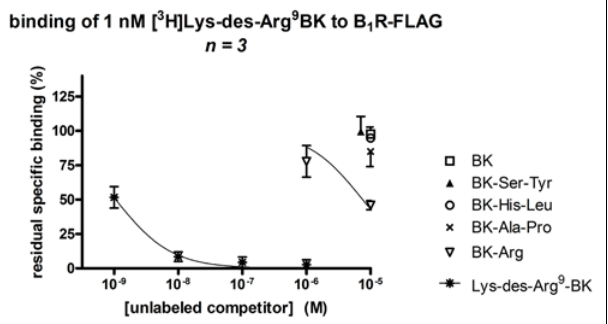
FIGURE 6 | Competition of [ 3 H]Lys-des-Arg 9 -BK (1 nM) binding to transiently expressed human B 1 R (B 1 R-FLAG vector) in HEK 293a cells by C-terminally prolonged BK analogs. For comparison, unlabeled BK and Lys-des-Arg 9 -BK, the prototypical agonists of the B 2 R and B 1 R, respectively, were also used as competitors. Results are expressed as the residual specific bindings (means ± SE of three duplicate determinations).